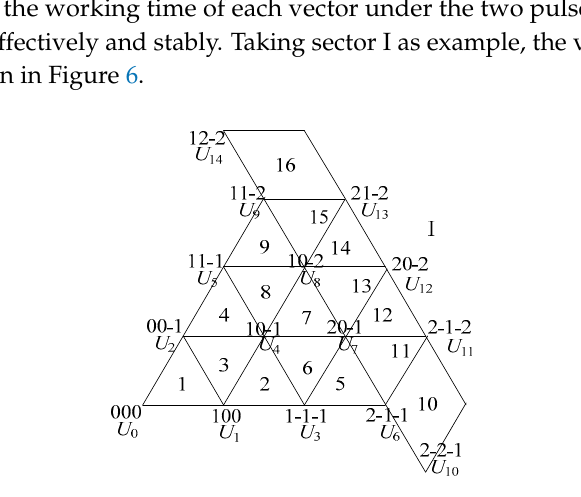
Figure 6. The vectors with the minimum common-mode voltage (CMV) in Sector I.